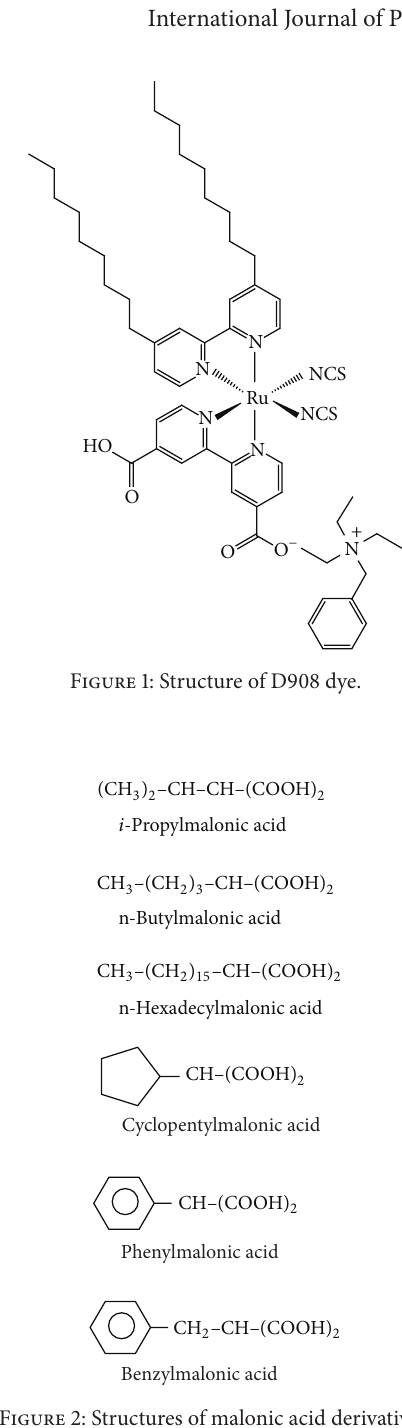
Figure 2: Structures of malonic acid